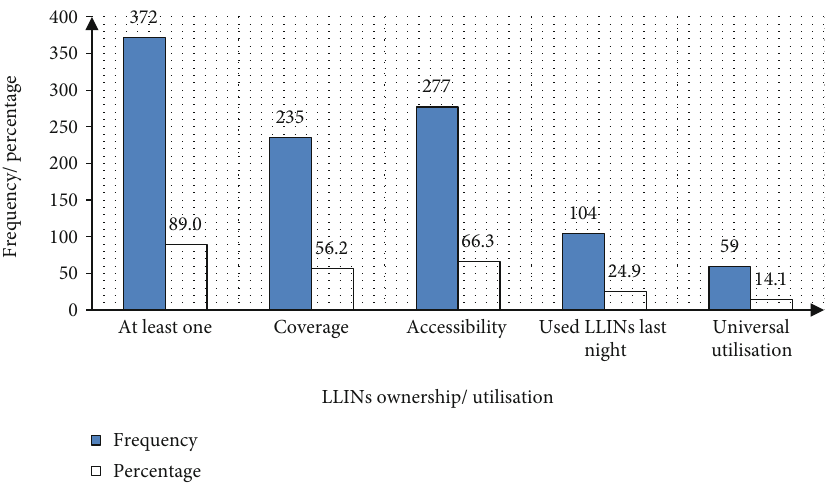
Figure 2: Household ownership and utilisation of LLINs. Table 3: Association of sociodemographic characteristics with LLIN ownership and